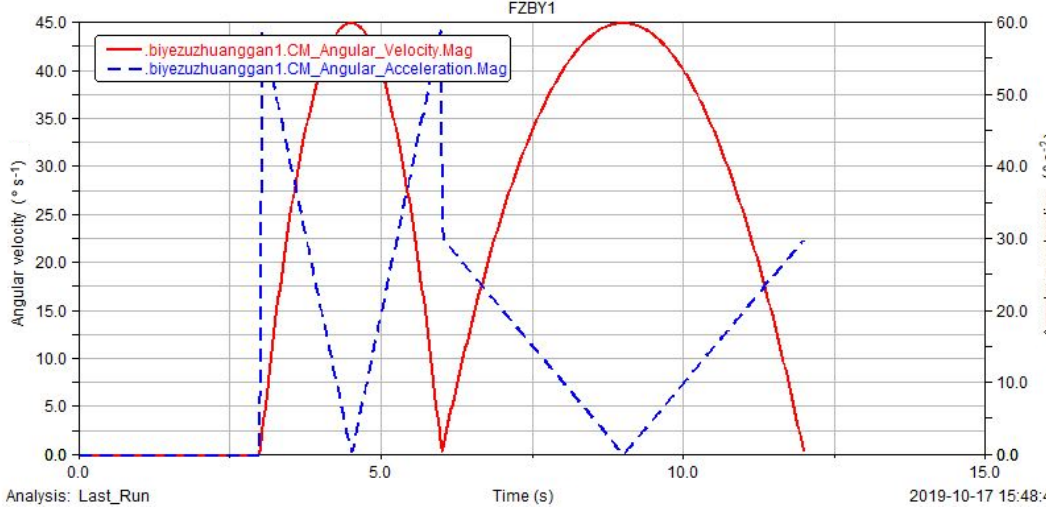
Figure 21. Change curve of angular velocity and acceleration of robot truss assembly.